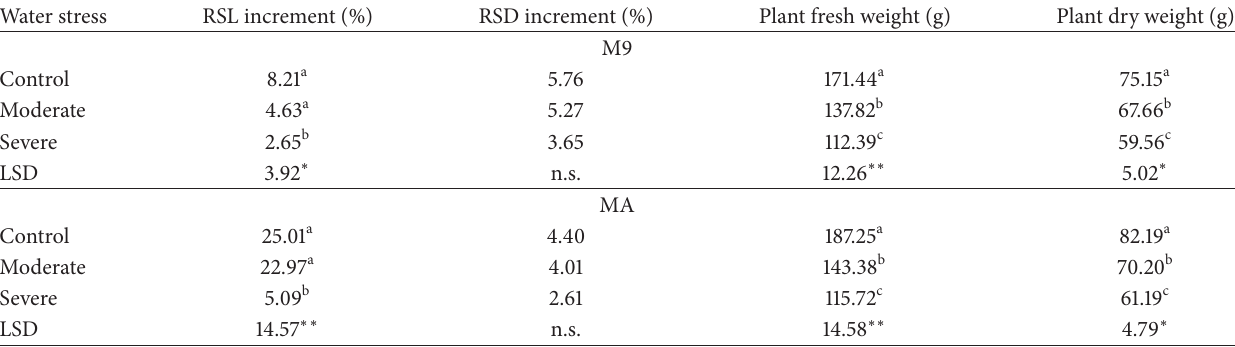
Table 1: The effects of water stress on M9 apple and MA quince rootstocks increment of relative shoot length (RSL), and relative shoot diameter (RSD), and plant total fresh and dry weights.